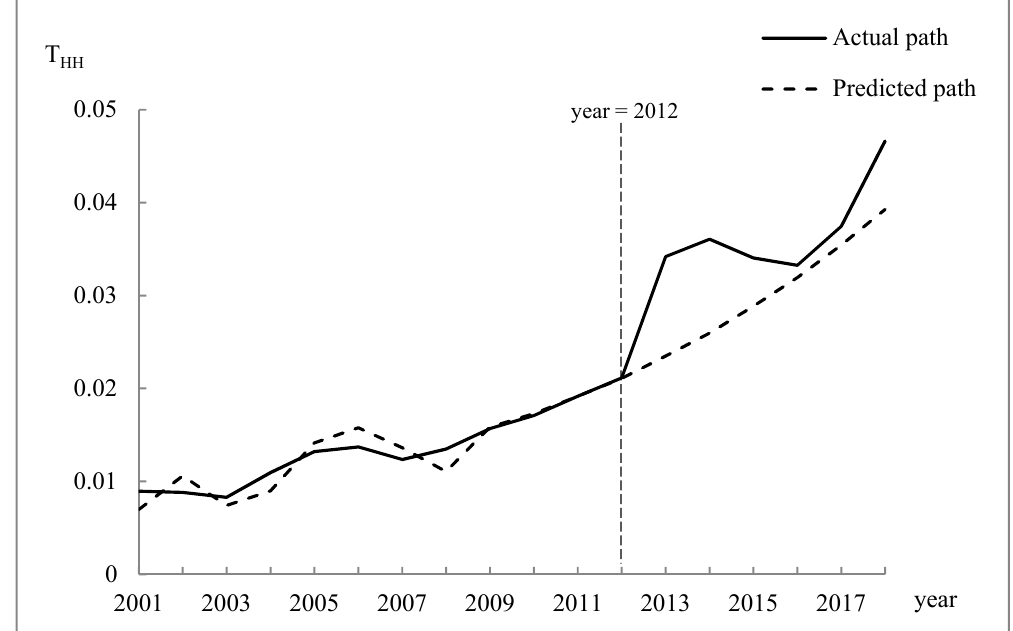
Figure 2. Actual and predicted paths of the T HH index from 2001 to 2018. Table 2. Significance tests for the ARIMA model for T HH